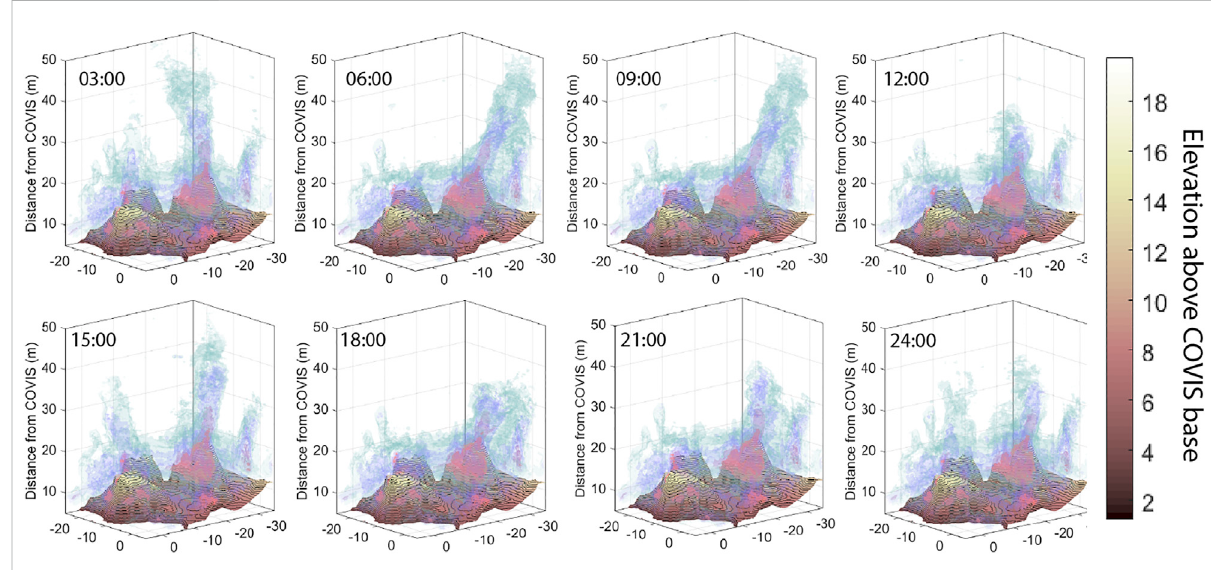
FIGURE 3 Comparisonofplumebendingazimuthfor1month(October)from2010to2014.Eachsubplotshowsahistogramofallplumeobservationsfor that year using 2 ° bin widths and normalizing to the total number of observations in a year. The predominant direction shifts from variable (2010) to northward fl ow with signi fi cant southward fl ow (2011 – 2012) to almost entirely northward fl ow (2013 –